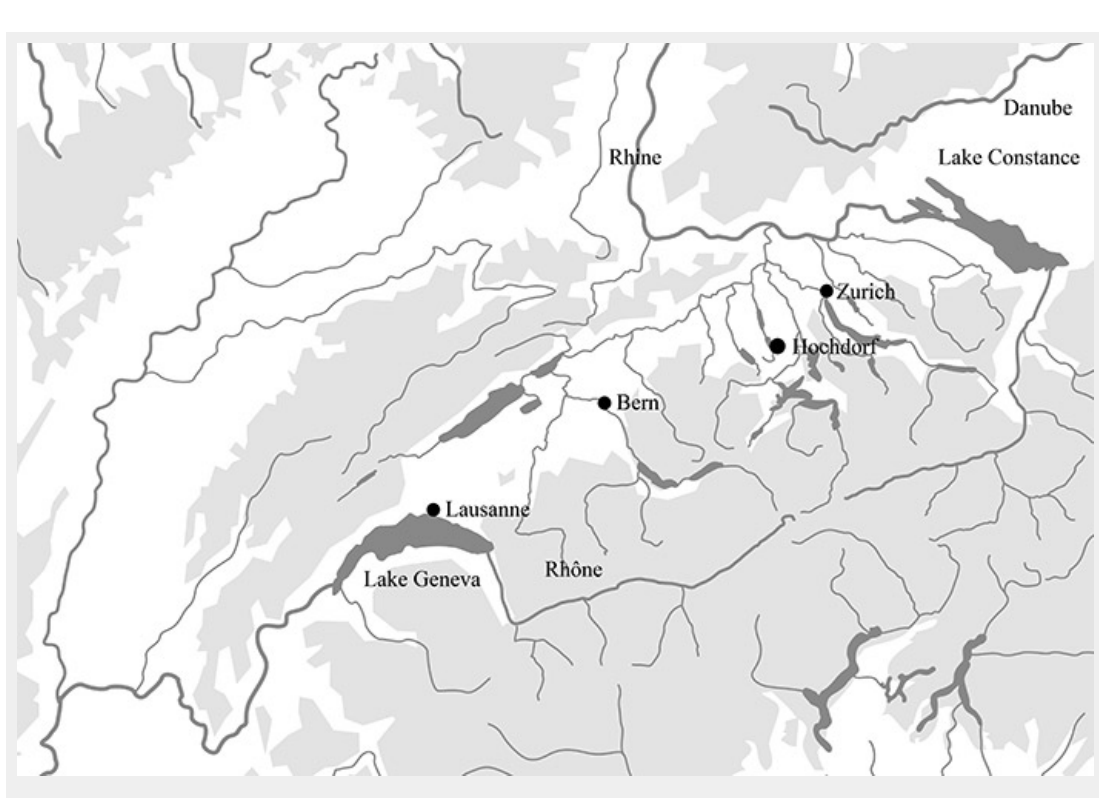
Figure 1 Location of Hochdorf, Canton Lucerne in